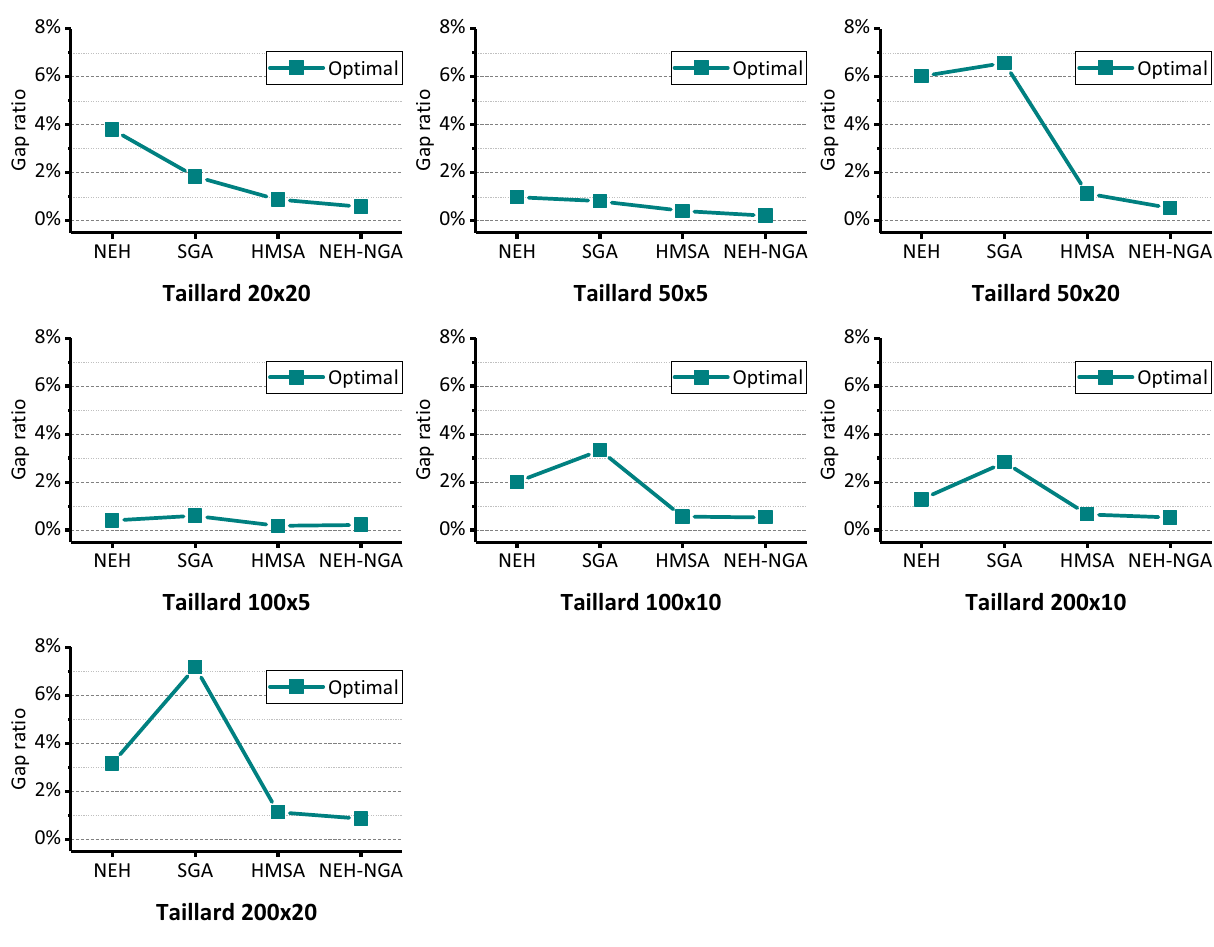
Figure 8. Comparison on Taillard benchmarks.